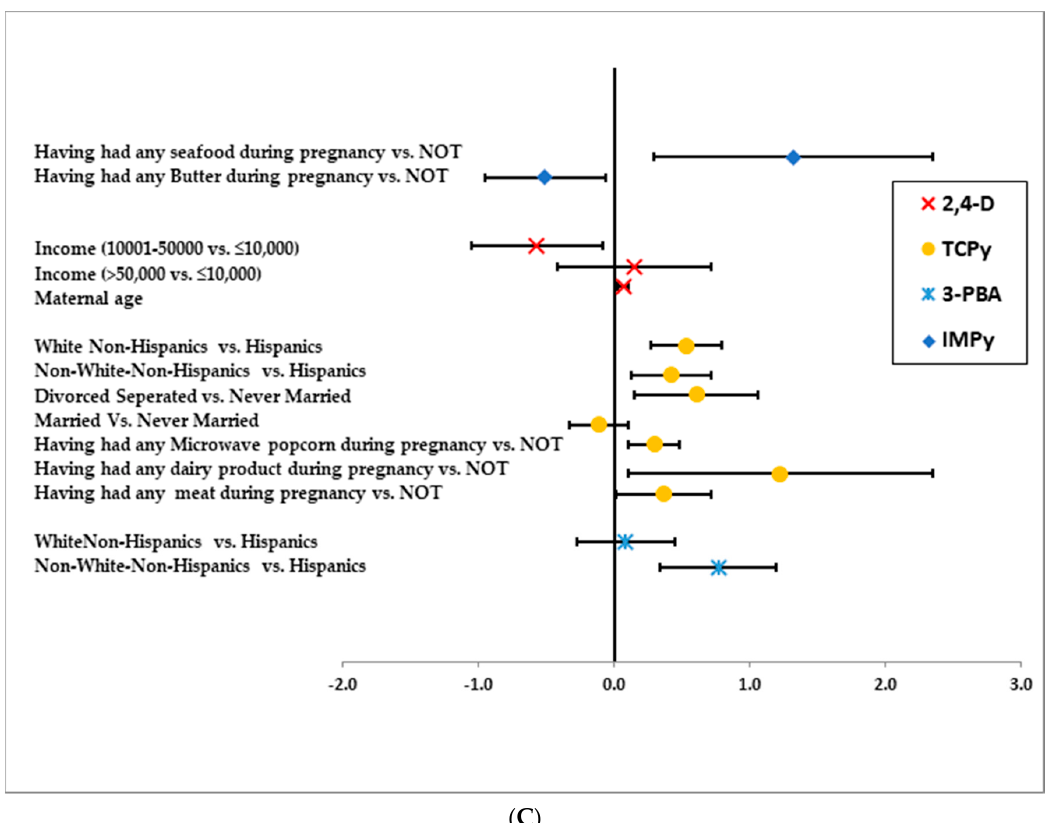
Figure 3. ( A ) . Predictors of Concentrations of organophosphate and pyrethroid pesticides in TDID cohort identified with logistic models ( ≥ median vs. <median [Reference category]) MODEL A. ( B ) . Predictors of Concentrations of organophosphate and pyrethroid pesticides in TDID cohort identified by linear model with < LOD imputed by/ √2 (MODEL B). ( C ) . Predictors of concentrations of organophosphate and pyrethroid pesticides in TDID cohort identified by regression models with lower values censored by LOD. * No predictors were selected by backward elimination procedure with the model for 2,4-D.